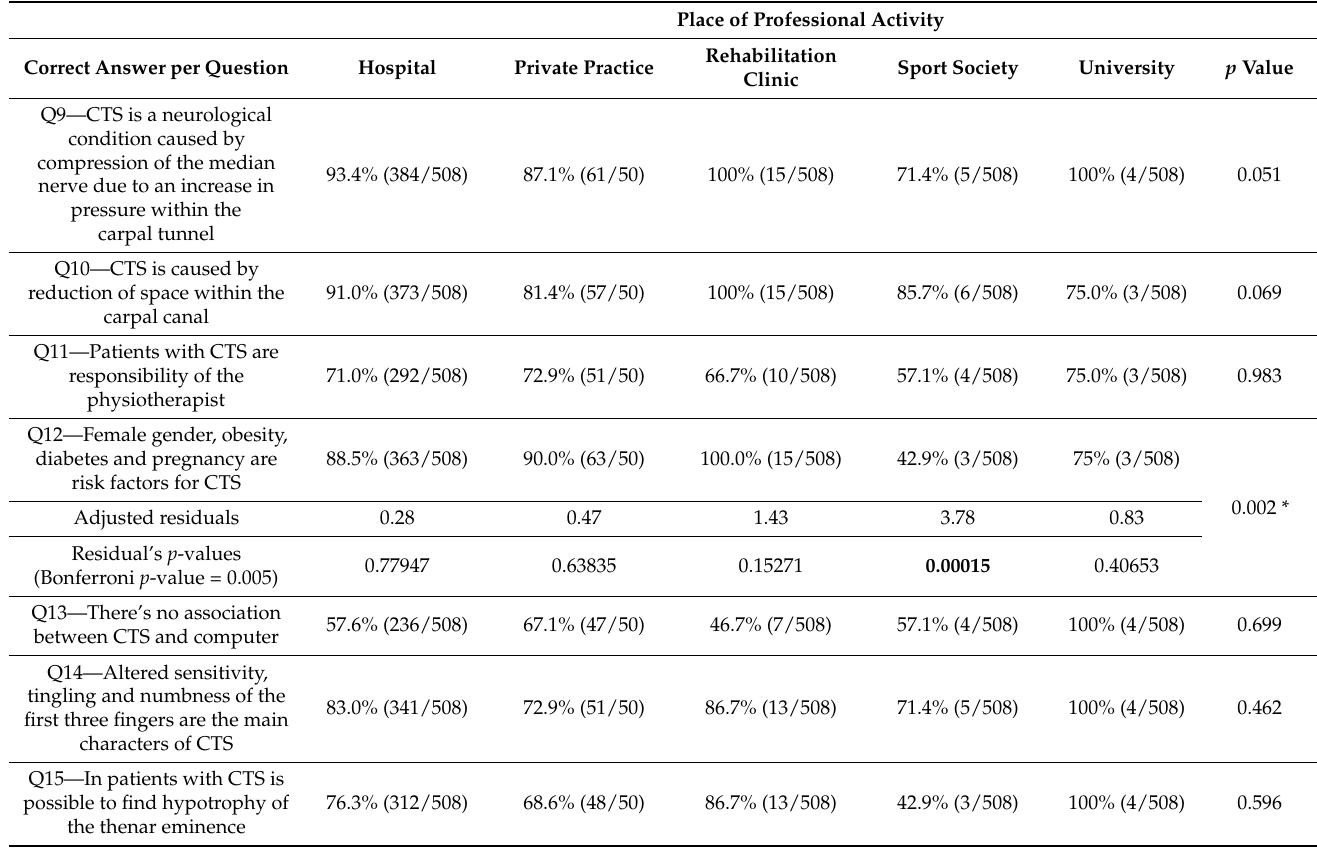
Table 3. Inferences between correct answers and place of professional activity of the